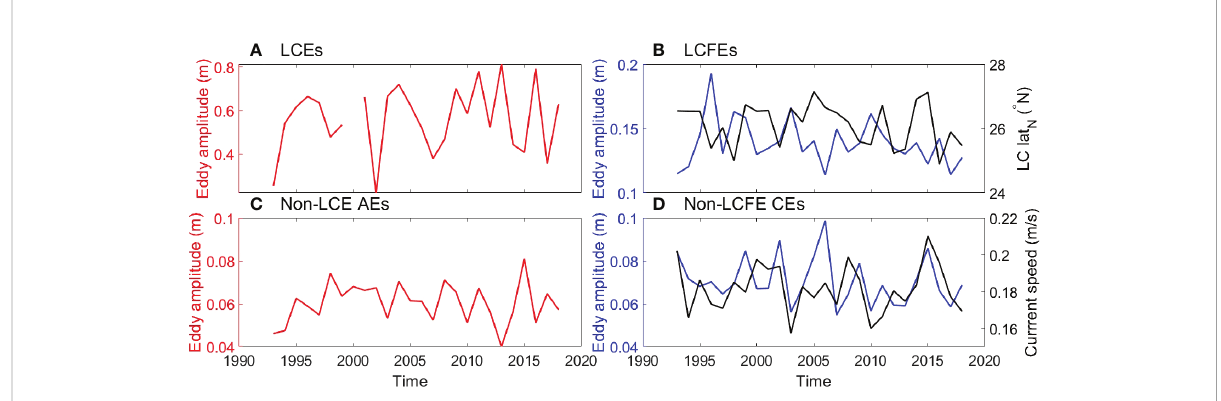
FIGURE 15 Annual median amplitude (m) of the (A) LCEs, (B) LCFEs, (C) non-LCE AEs and (D) non-LCFE CEs when they were generated. The black line represents the annual mean northern boundary (°N) of the LC in (B) and the annual mean current speed (m/s) in the western GoM in (D)